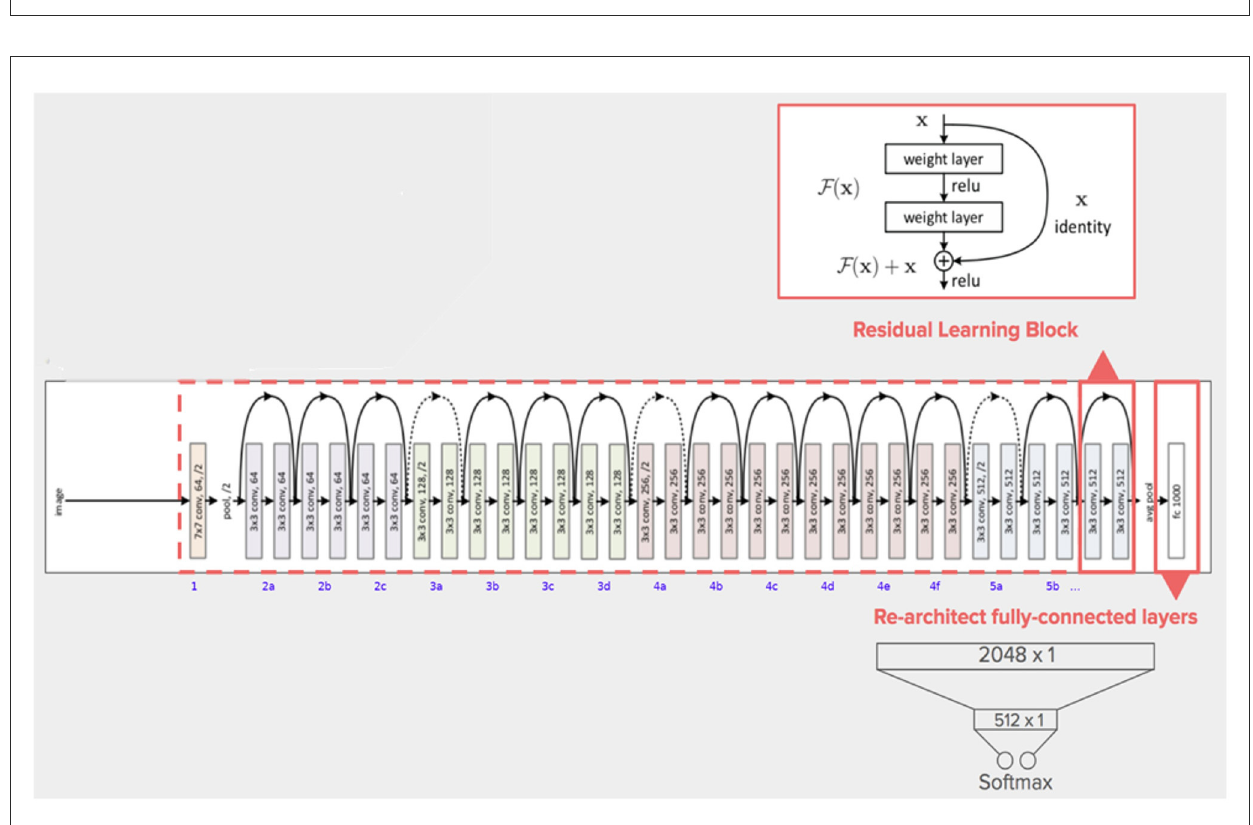
FIGURE8 The architecture of ResNet50 model (Khan et al., 2021).